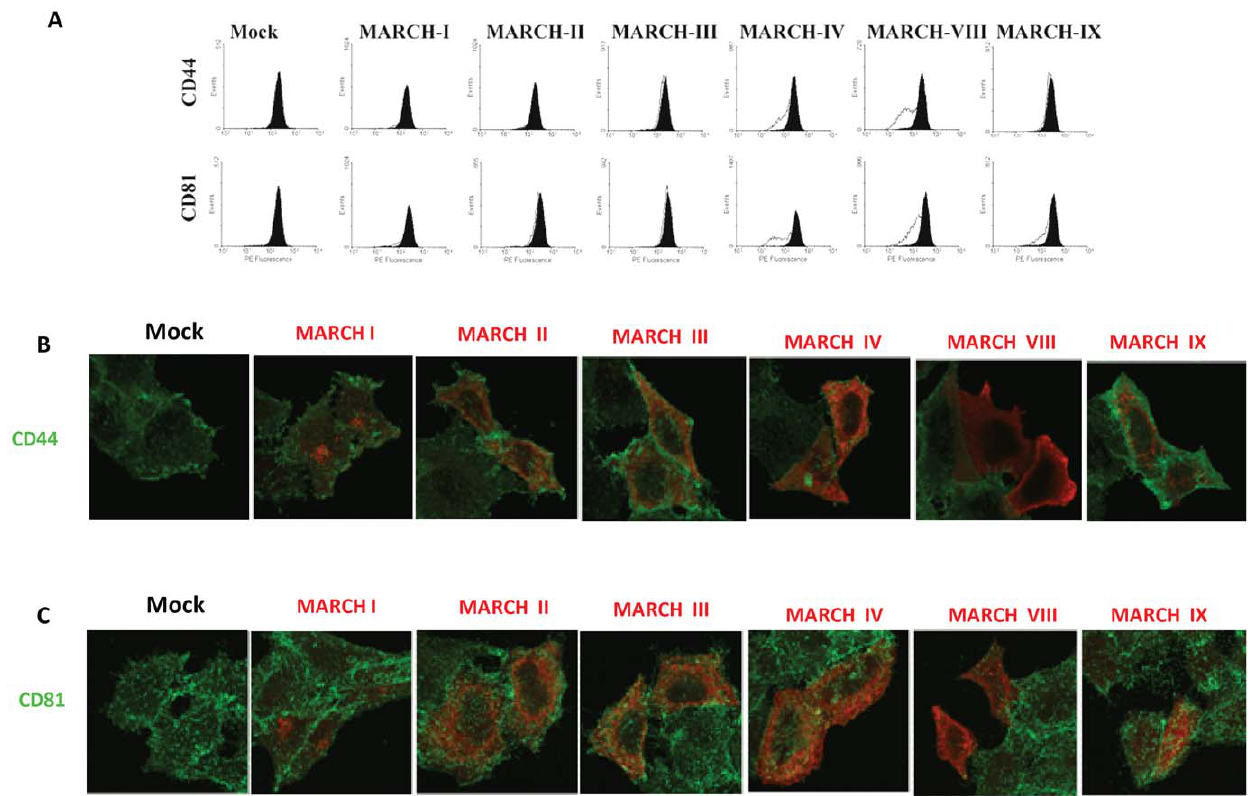
Figure 5. Downregulation of CD44 and CD81 by other members of the MARCH-family. HeLa cells were transfected with plasmids expressing cDNAs for each MARCH protein and the surface expression of CD81 and CD44 were assayed by flow cytometry (A) or confocal immune fluorescence analysis (B and C).